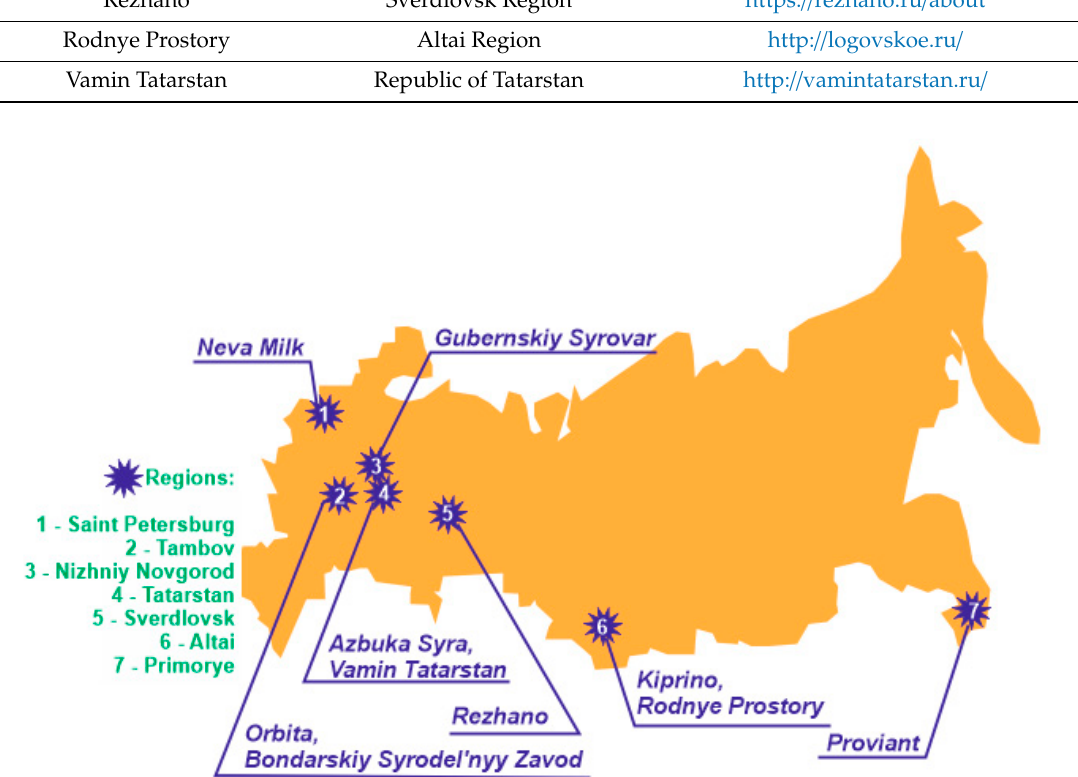
Figure 1. Regional distribution of the analyzed organizations.